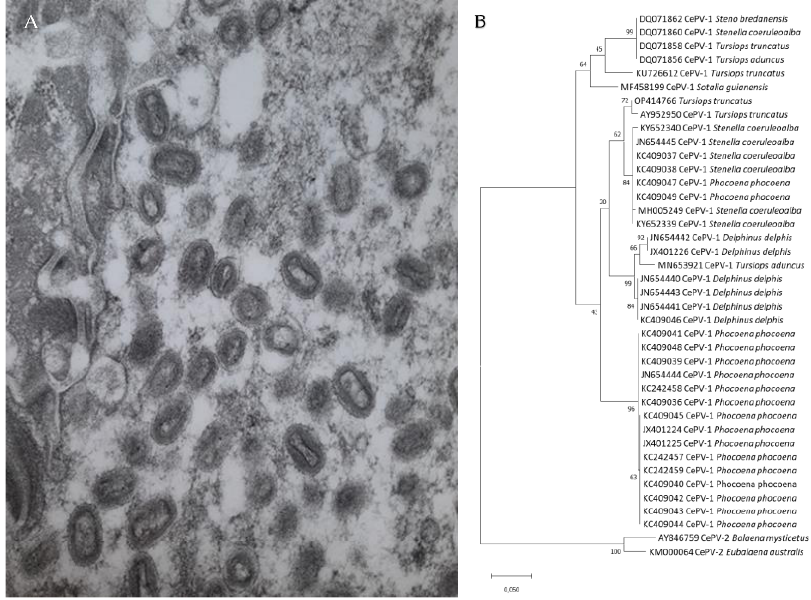
Figure 2. ( A ) Poxvirus particles in skin lesions of Burmeister’s porpoise ( Phocoena spinipinnis ) MFB- 499 from central Peru (15,000 x magnification); ( B ) Phylogenetic tree among DNA polymerase nucleotide sequences of cetacean poxviruses available in GenBank “ adapted with permission from [10]. 2022, L. Luciani ” .